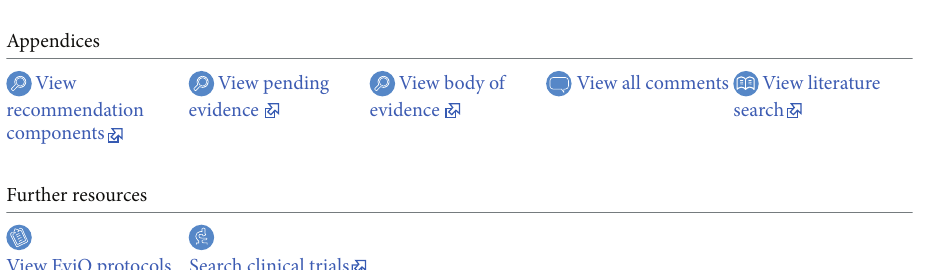
Figure 2: Appendices associated with each clinical